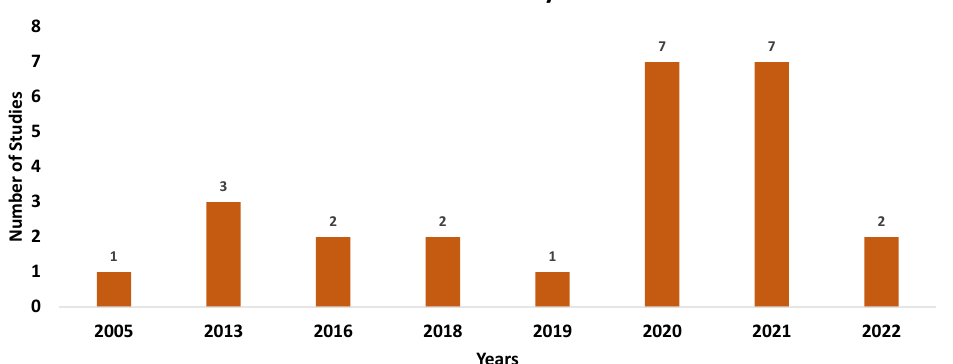
Figure 4. Number of review studies observed in the literature on VR, AR, and MR in condition assessment of civil structures over the years.